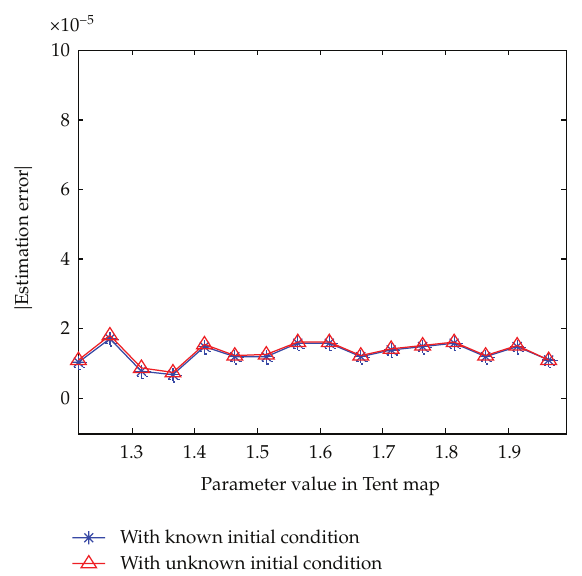
Figure 5: Comparison of improved MVM with and without the knowledge of initial condition; the chaotic map is the Tent map.